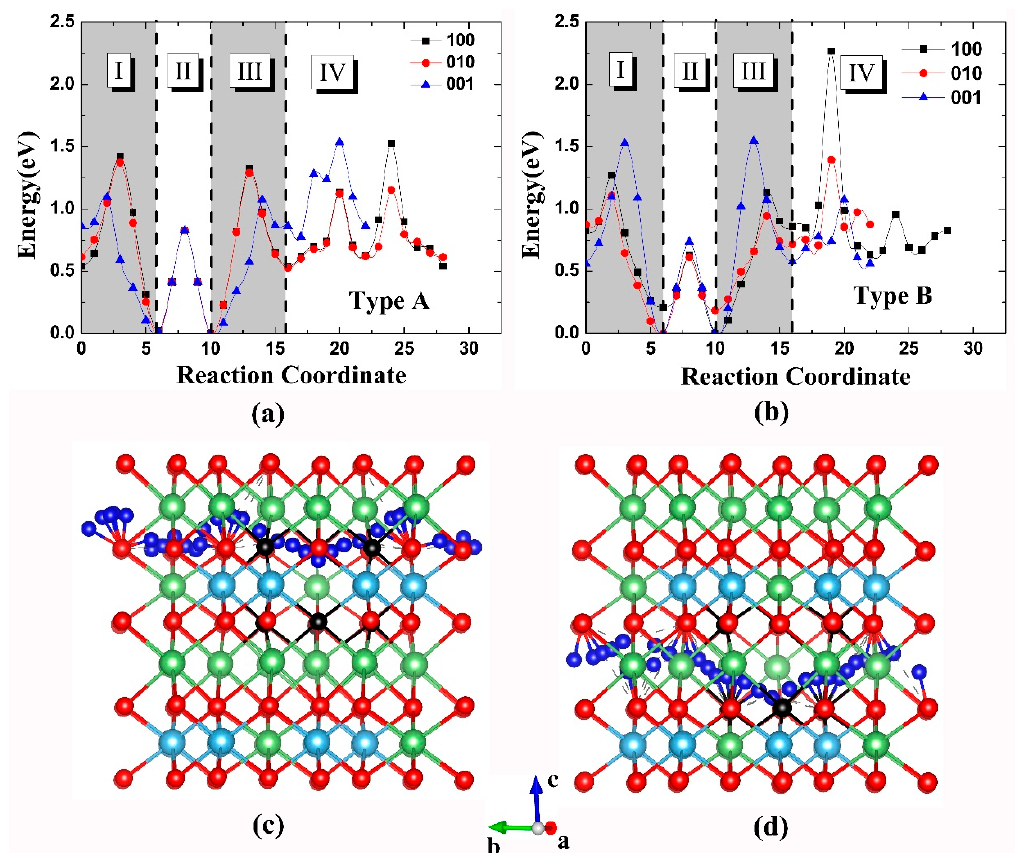
Figure 4. ( a – b ) The energy barrier of three tritium diffusion paths with the direction of [100], [010], and [001] in the crystal with the vacancy of type A or B (color online). Parts I–IV are separated by vertical dashed lines. ( c – d ) The diffusion pathway along the [010] direction in the crystal with the vacancy of type A or B.